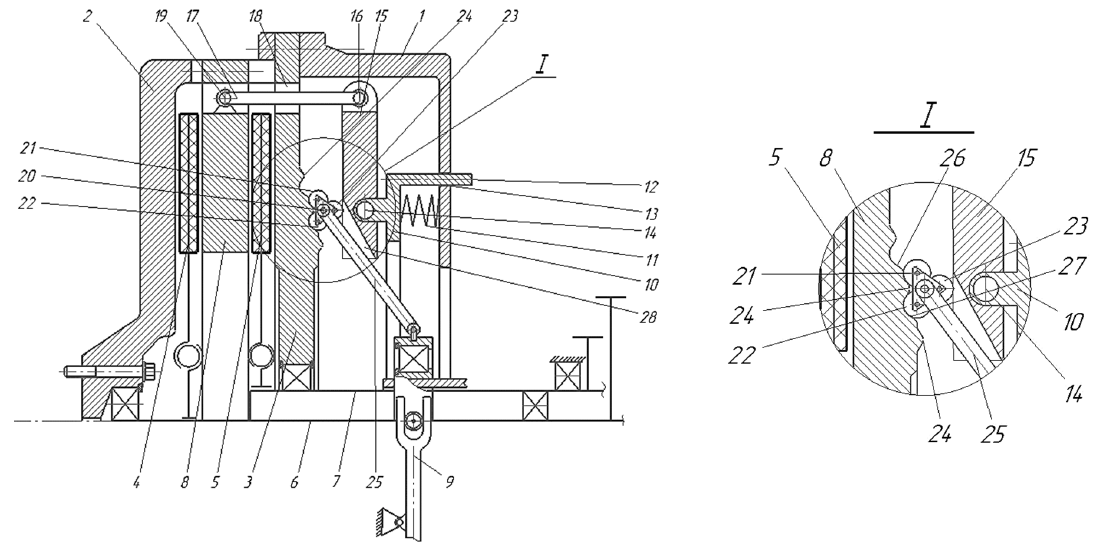
Figure 2. The original DCT design: 1—casing; 2—flywheel; 3—platter; 4,5—driven discs; 6, 7—shafts; 8—pressure plate; 9—drive mechanism; 10—additional disc; 11—pressure springs; 12—elements; 13, 18—holes; 14, 16, 19—hinges; 15—rotary stops; 17, 25—levers; 20—movable supports; 21–23—rollers; 24—clamps; 26, 27—surfaces; 28—inclined grooves.